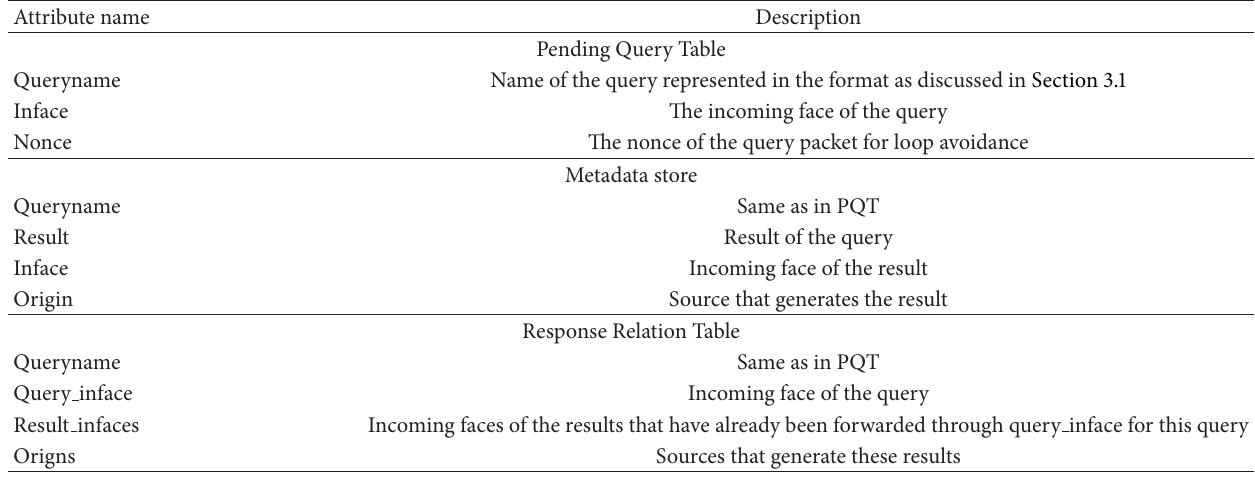
Table 2: Major attribute names and their descriptions for the PQT, RRT, and metadata